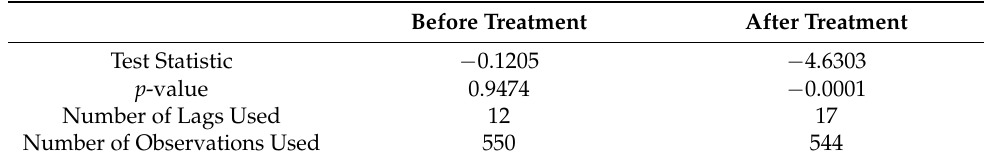
Table 3. Results of DF test for SCFI.